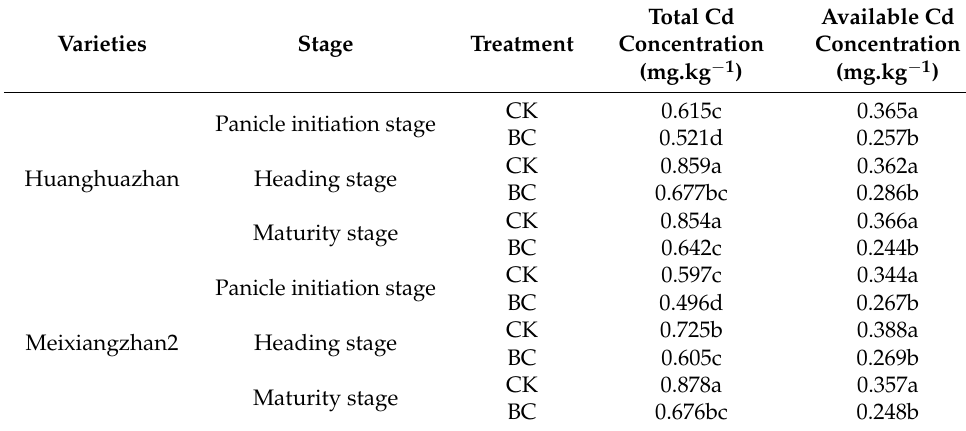
Table 3. The content of Cd in different periods by biochar